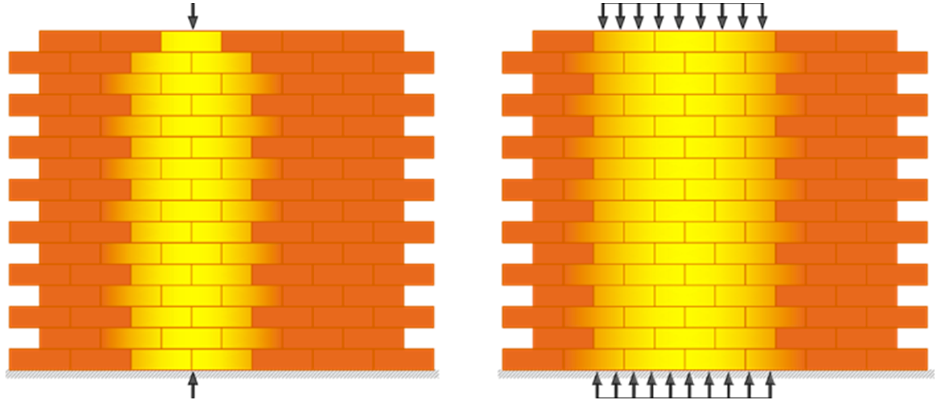
Figure 1. Weak dispersion of point and distributed loads within masonry walls.